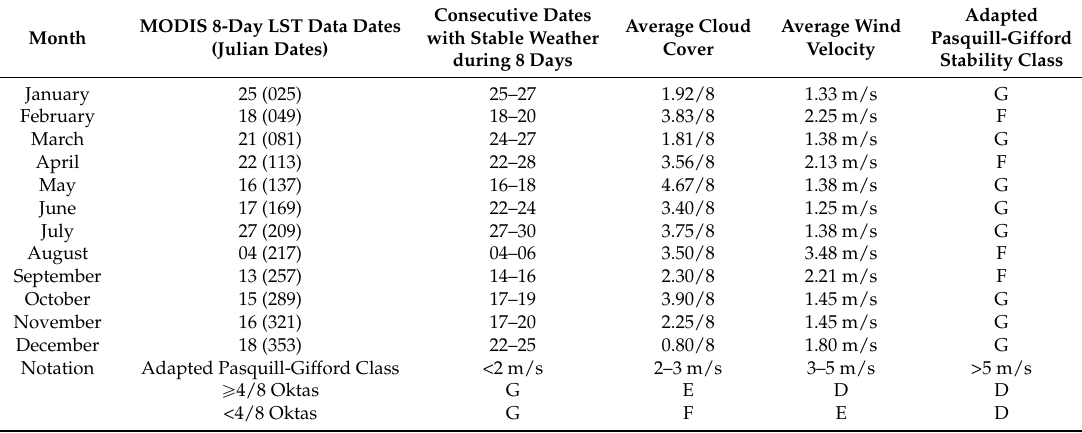
Table 1. Selected image data and the corresponding weather